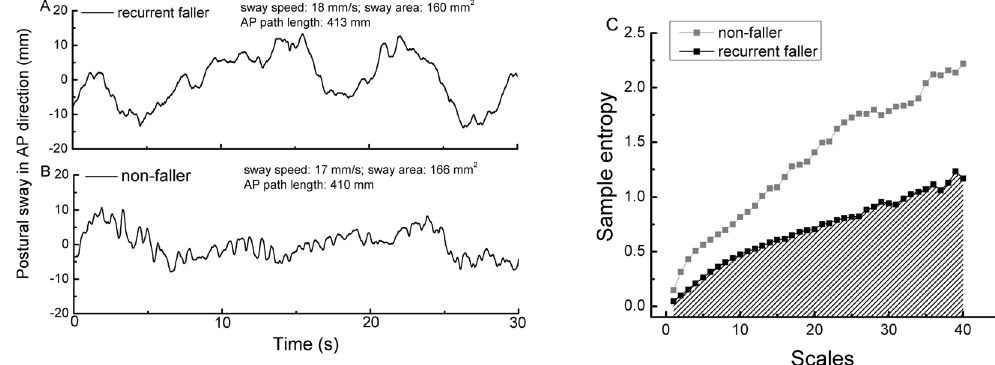
Figure 1. Illustrative anterioposterior (AP) postural sway time-series of a recurrent faller ( A ) and a non-faller ( B ) during single task quiet standing along with multiscale entropy (MSE) curves generated from each time- series ( C ). To quantify the different postural sway dynamics of the time series in A and B, sample entropy was calculated and plotted as a function of time scales (ranging from scale 1 to 40) for each time-series. Postural sway complexity was defined as the area under the multiscale entropy curve, as illustrated by gray shading under the curve of the recurrent faller. When compared to the non-faller, sample entropy of this recurrent faller was lower across multiple time scales. Postural sway complexity (i.e., area under the multiscale entropy curve) of this recurrent faller (complexity = 27.5 units) was nearly half that of the non-faller (complexity = 52.8 units) while other postural sway metrics (i.e., sway speed, area and AP path length) of the two participants were similar (listed on the top of A and B).